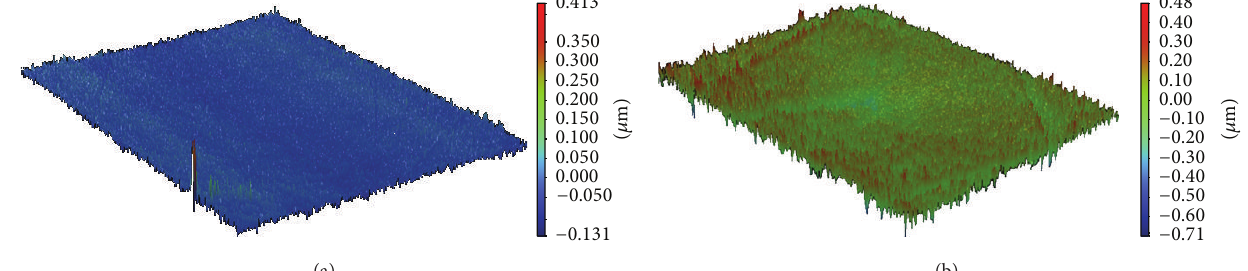
Figure 7: Optical 3D photos of Ti alloys: (a) Ti-6Al-7Nb and (b)